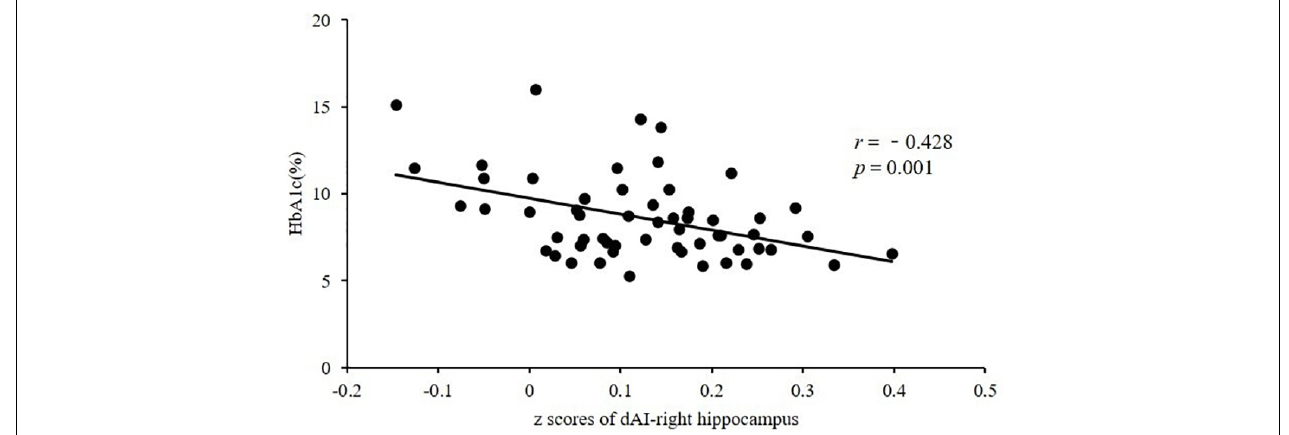
FIGURE 2 | Significant negative correlation between HbA1c and FC in the dAI and right hippocampus in subjects with T2DM ( r = − 0.428, P = 0.001). HbA1c, glycated hemoglobin; FC, functional connectivity; dAI, dorsal anterior insula; T2DM, type 2 diabetes